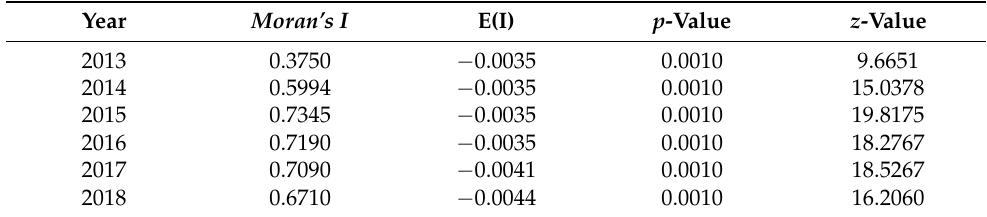
Table 5. Moran’s I estimate of the level of human settlements from 2013 to 2018.